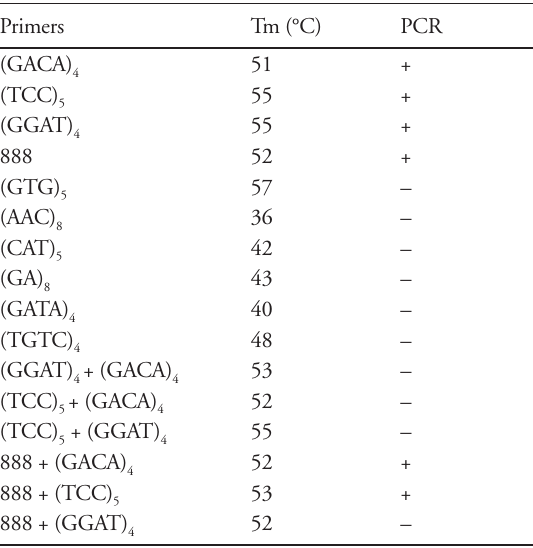
Table 2. Primers, annealing temperatures (Tm) used in this study and PCR results (+ = successful DNA amplification, – = primer failed to amplify E. andevalensis